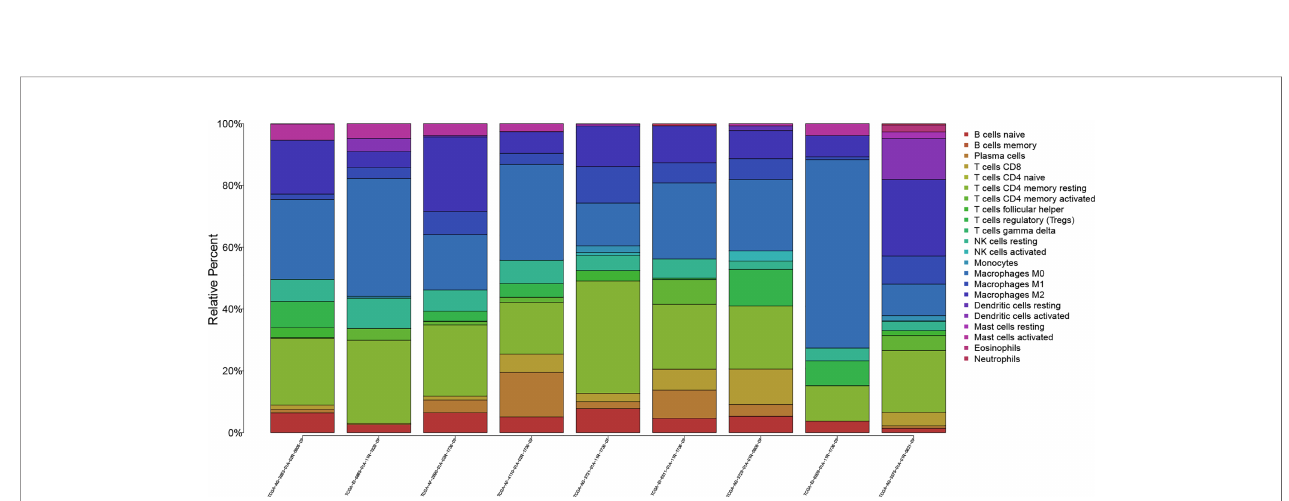
FIGURE 2 | The proportions of 22 kinds of TICs in rectal tumor